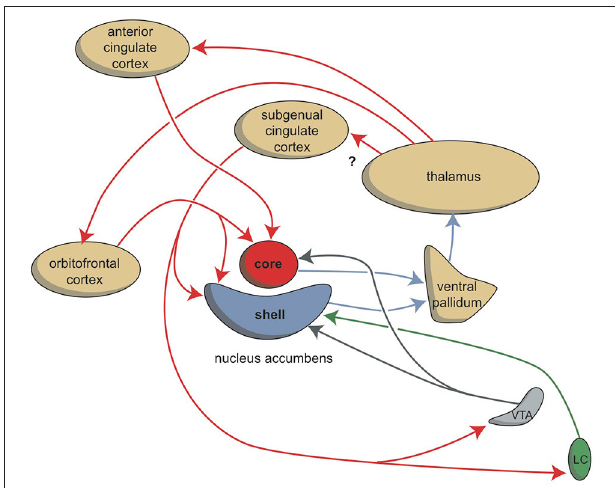
FIGURE 8 | Cortico-striatal-thalamo-cortical re-entry circuits including core and shell parts of the nucleus accumbens. The existence of the re-entry circuit including the subgenual cingulate cortex is still hypothetical. LC, locus coeruleus; VTA, ventral tegmental area. Red arrows, glutamatergic; blue arrows, GABAergic; green arrows, adrenergic; gray arrows,